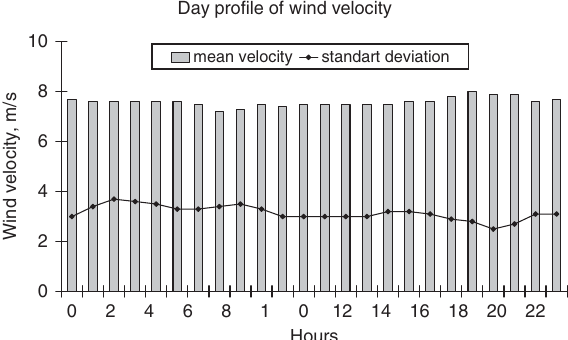
Fig. 4. Day profile of wind velocity in Giruliai at 50 m height above ground level